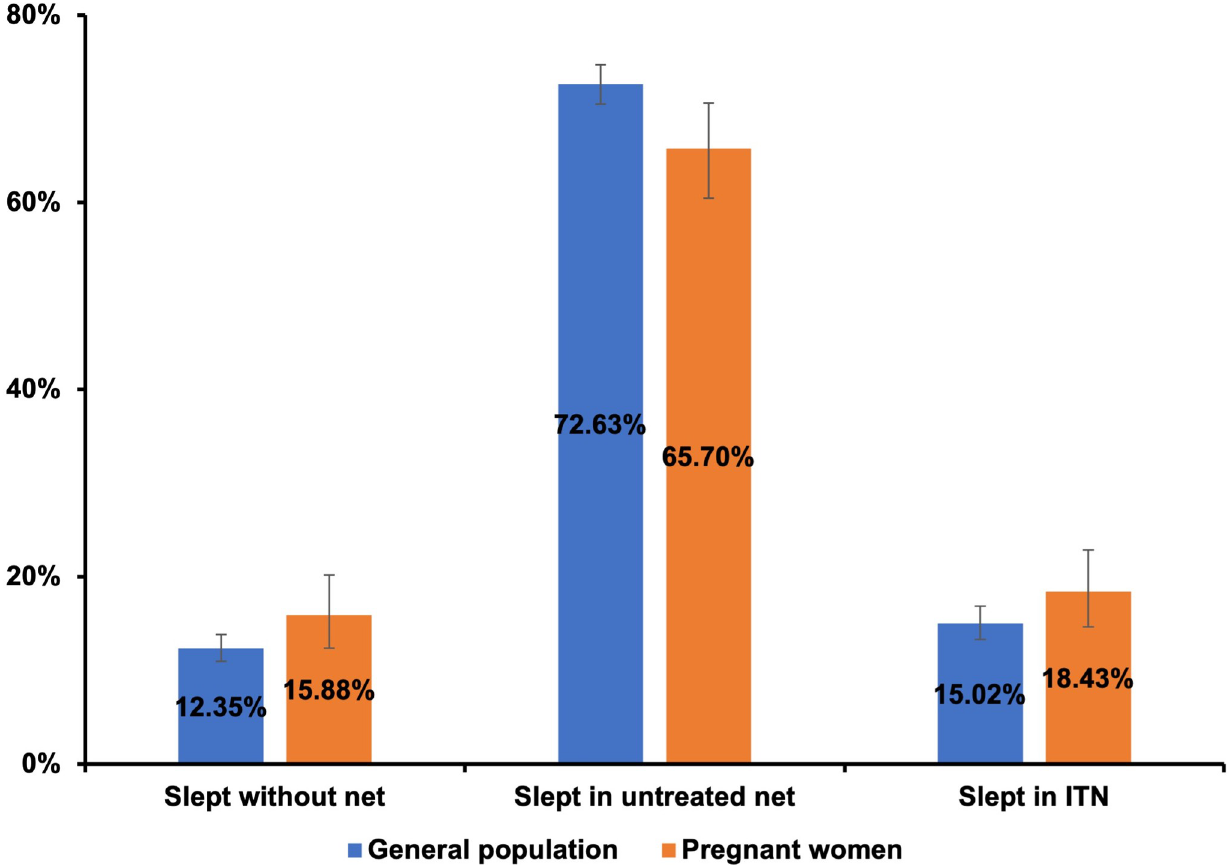
Fig 1. Comparison of bed net utilization between the general population and pregnant women involved in the Myanmar Demographic and Health Survey 2015–16